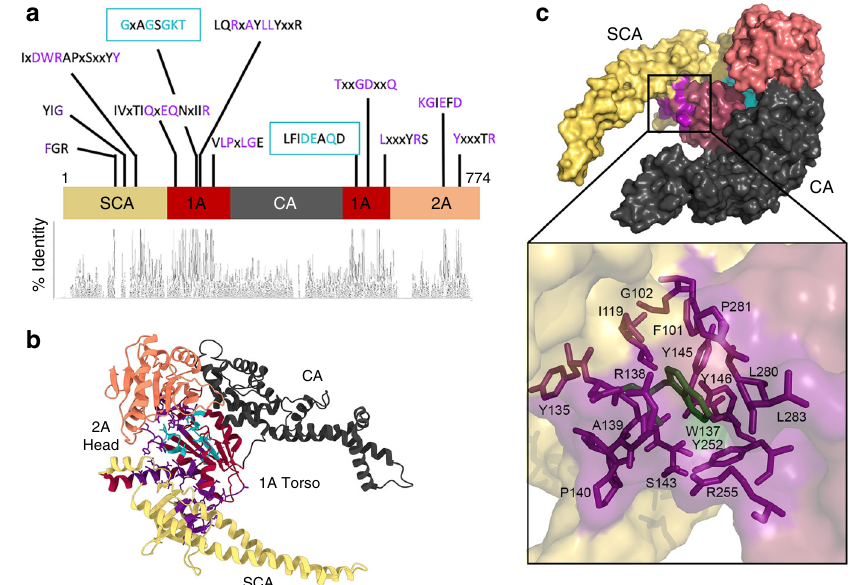
Fig. 3 Structure and sequence conservation of HelD. a Linear representation of the structure of HelD with a map of coloured domains and conserved sequence motifs (top), and a histogram of sequence identity (bottom). b The structure of HelD (bottom) coloured according to the schematic in panel a . SCA is shown in yellow, SF1 helicase-like domain 1 A in red, CA in dark grey, and SF1 helicase-like domain 2 A in orange. Conserved sequence motifs are shown in purple, with the Walker A/B ATP-binding site in cyan. c , shows a surface-rendered impression of HelD with the same colouring as in b . The bottom panel shows an expanded view of the boxed region in the top panel with a semi-transparent surface and conserved amino acids that form the ‘ Trp cage ’ shown as purple sticks, and the conserved Trp in dark